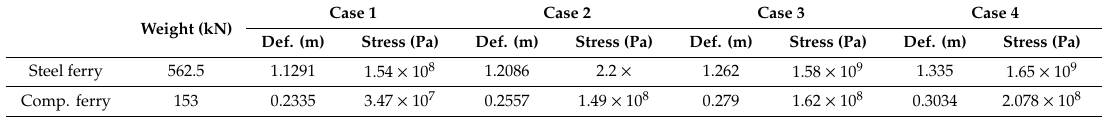
Table 3. The results of the steel ferry and the composite